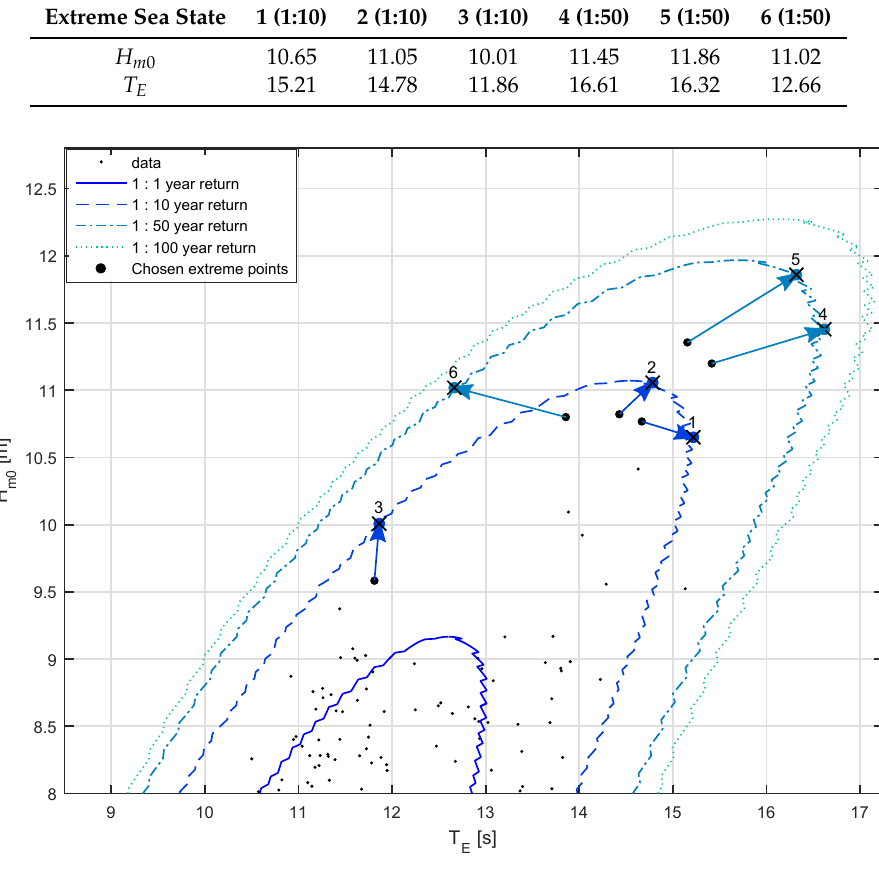
Figure 6. Bivariate extreme contours with data points identified that have been chosen for scaling (large black circles). Crosses on the contours show the desired H m 0 – T E values (Table 1), and arrows indicate which observed sea state is chosen to match each specified extreme